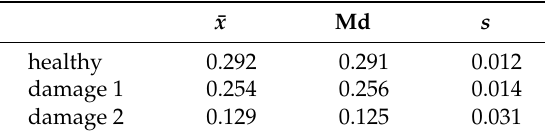
Table 2. Statistical data for all the scenarios at 5